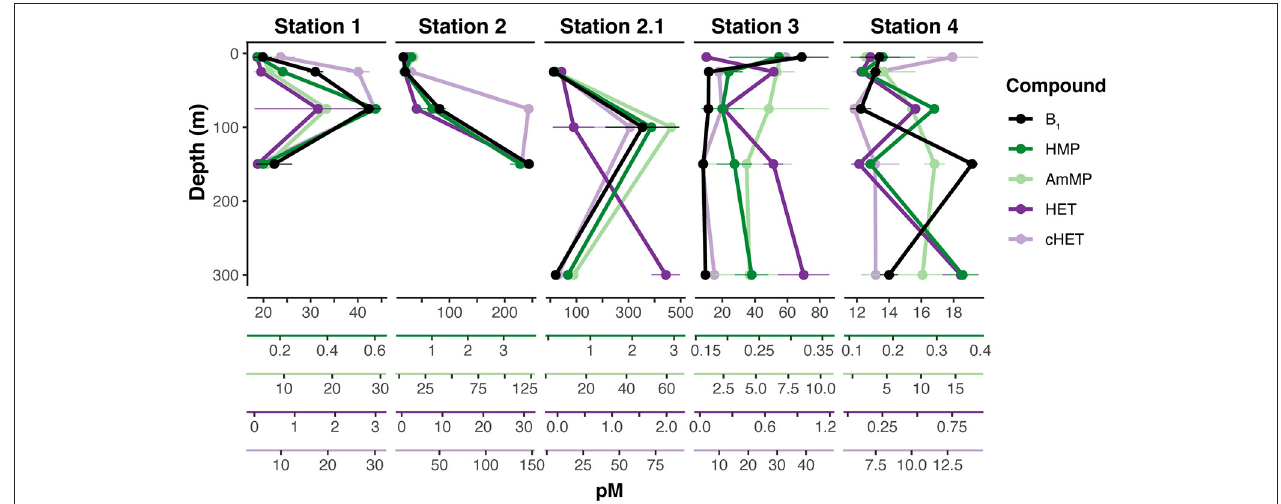
FIGURE 3 | Dissolved Thiamin Related Compound (TRC) depth distributions. Vertical distributions are over-plotted using separate axis to highlight the similarities in TRC distribution trends. Thiamin (B1) is plotted in black, the pyrimidine TRCs (HMP and AmMP) are plotted in shades of green, and the thiazole TRCs (HET and cHET) are plotted in shades of purple. Axis color relates to the color of the depth profile. Points and error bars are means and standard deviations of technical replicates ( n = 3).